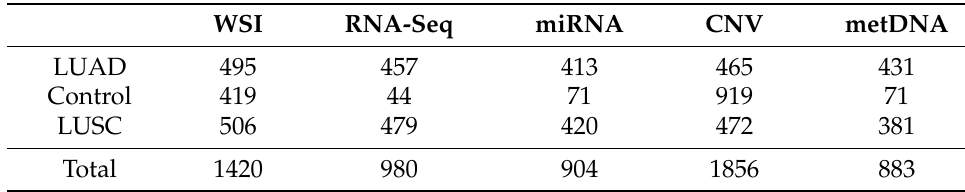
Table 2. Number of samples per class for each data modality.